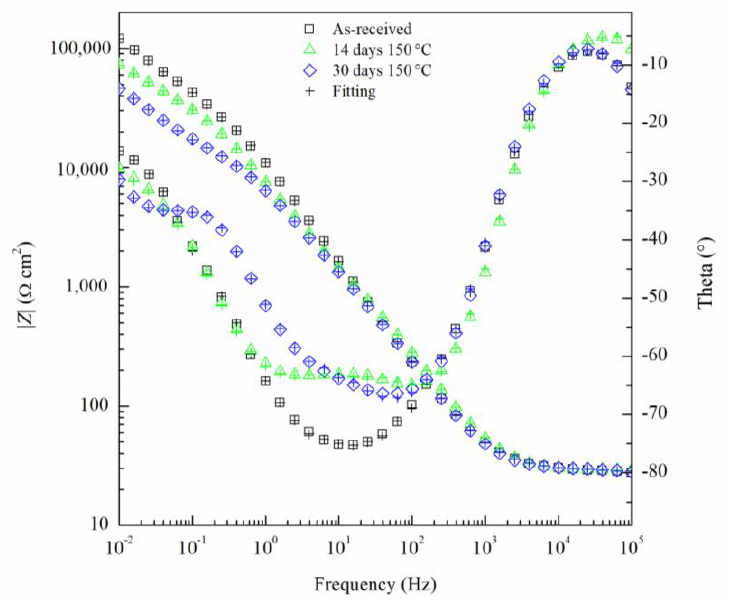
Figure 10. Bode plot for AA5083 in 3.5 wt% NaCl sensitized at 150 ◦ C for 0, 14 and 30 days. Cross marks represent EIS fitting results using